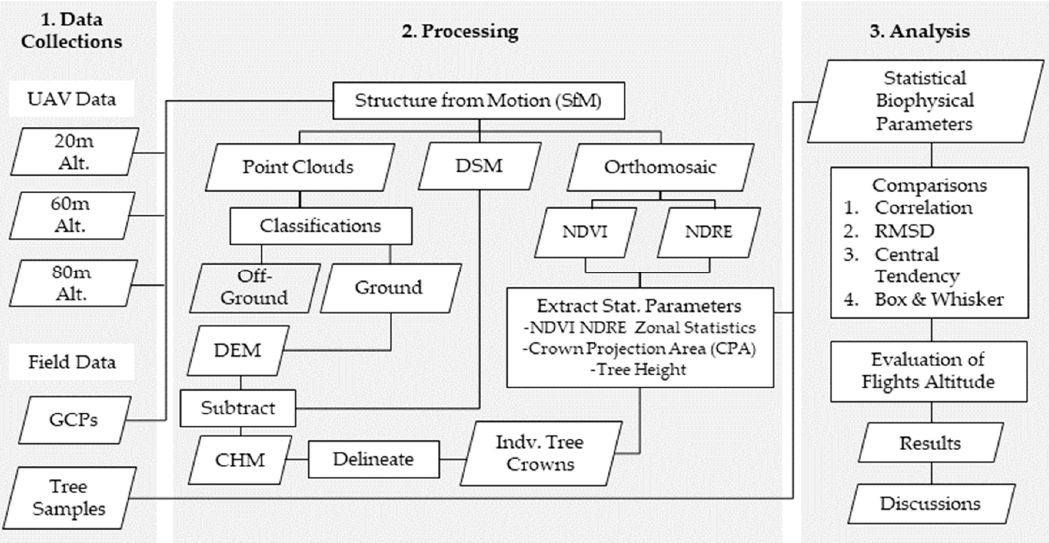
Figure 4. Flowchart of the methodology.